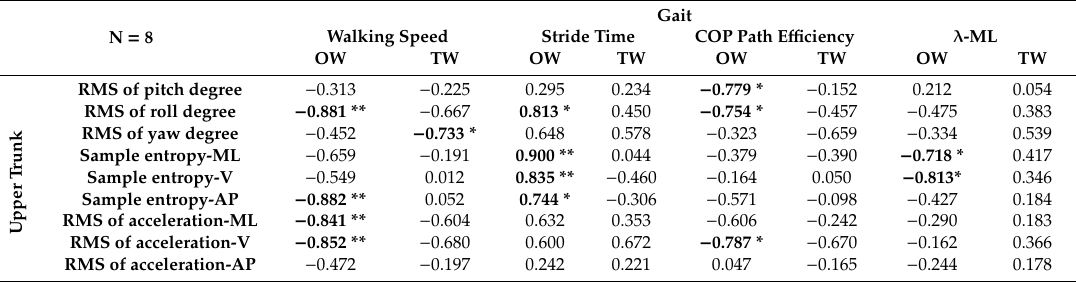
Figure 5. Comparison of upper trunk stability between TW and OW condition: ( a ) The maximal Lyapunov exponent of lumbar acceleration in ML, V and AP directions. ( b ) The RMS of lumbar acceleration in ML, V and AP directions. Table 8. Pearson’s correlation matrix between gait features and upper trunk features under OW and TW